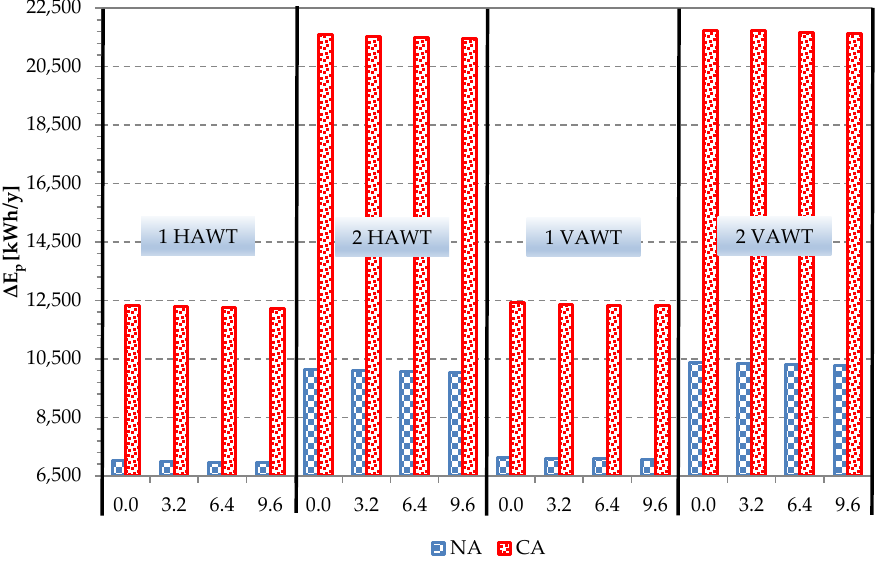
Figure 14. Primary energy demand reduction for both Naples and for Cagliari, as well as for WT configuration.